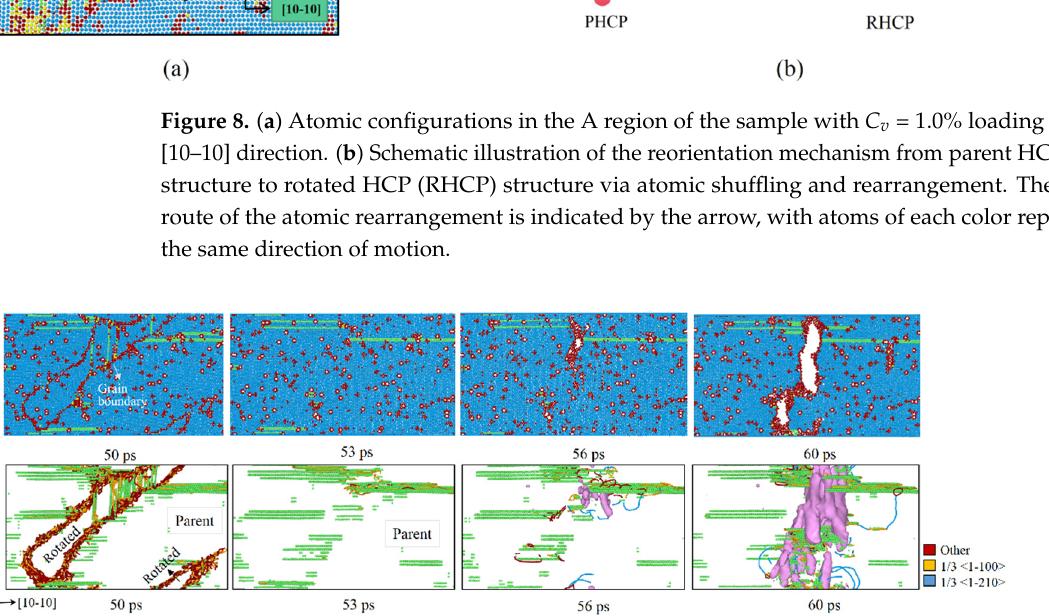
Figure 9. Void evolution of the sample with C v = 1.0% at different time points during initial spallation loading along the [10-10] direction. ( a ) Atomic configurations of a chosen section of the spall region. ( b ) Mechanism of void growth based on dislocation emission is analyzed using DXA: 1/3 <1 – 100> partial basal dislocations, 1/3 <1 – 210> partial prismatic dislocations, other dislocations (mainly 1/6 <20 – 23> and 1/9 <01 – 13> partial dislocations), etc., are presented.